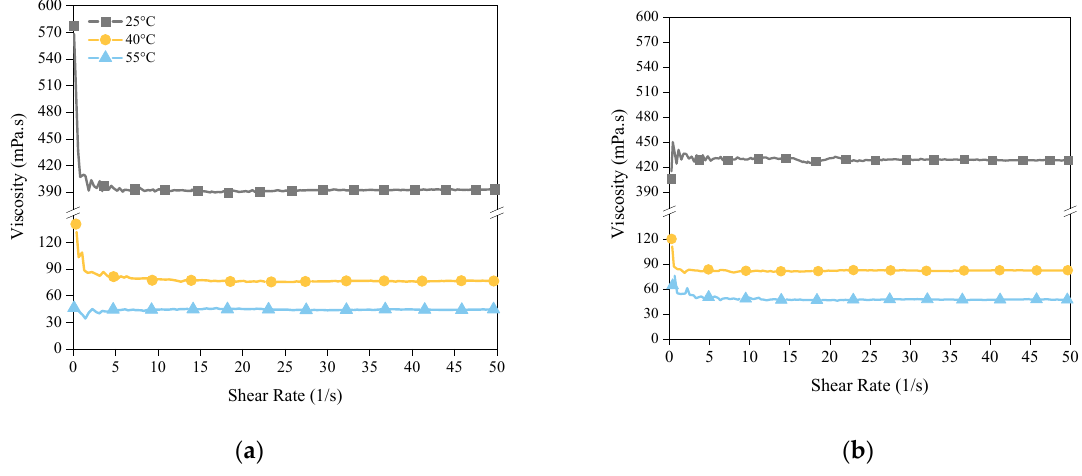
Figure 6. The viscosity of ( a ) Mixture A and ( b ) Mixture B at process temperatures of 25, 40, and 55 °C.